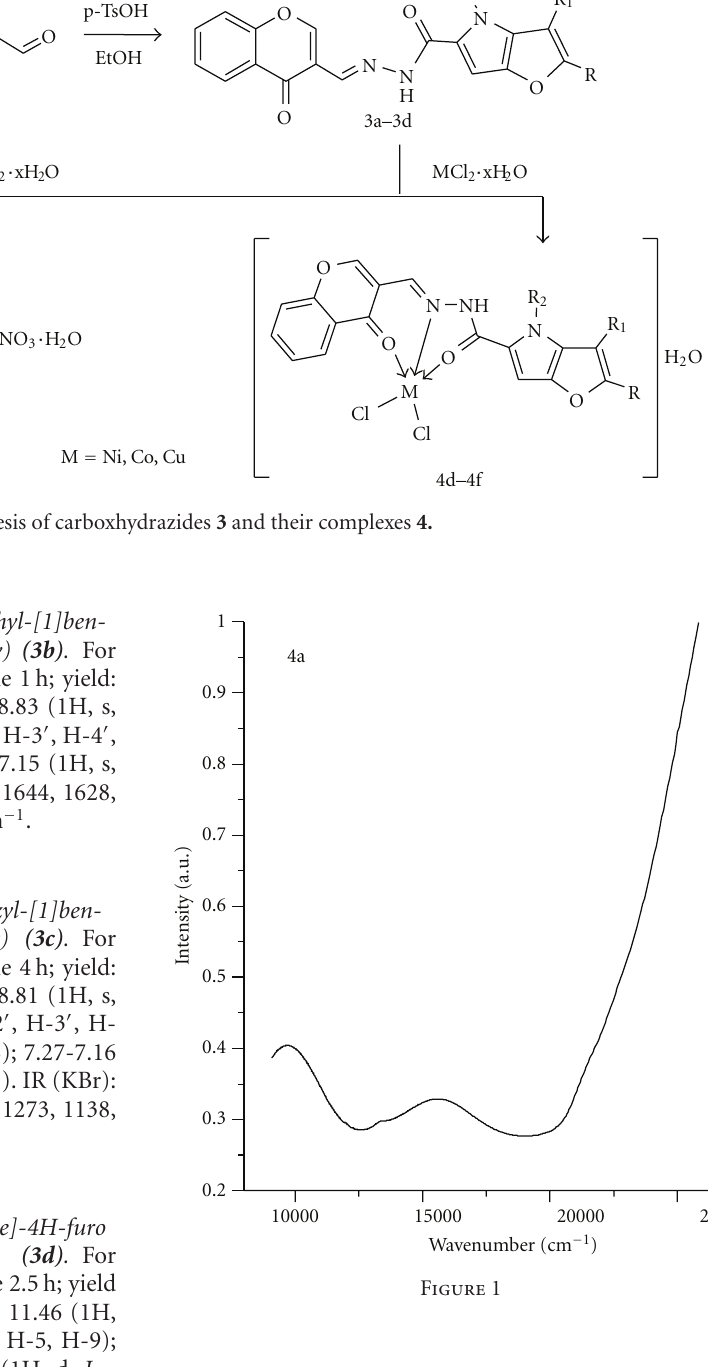
was added dropwise. Precipitate which was formed imme- diately, was filtered o ff , washed with acetone (3 × 15 cm 3 ), and